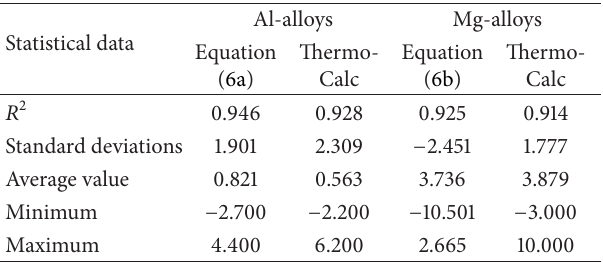
Table 4: Regression coefficients, standard deviations and average values of differences calculated between measured and analytically determined liquidus temperatures using method equivalency and Thermo-Calc